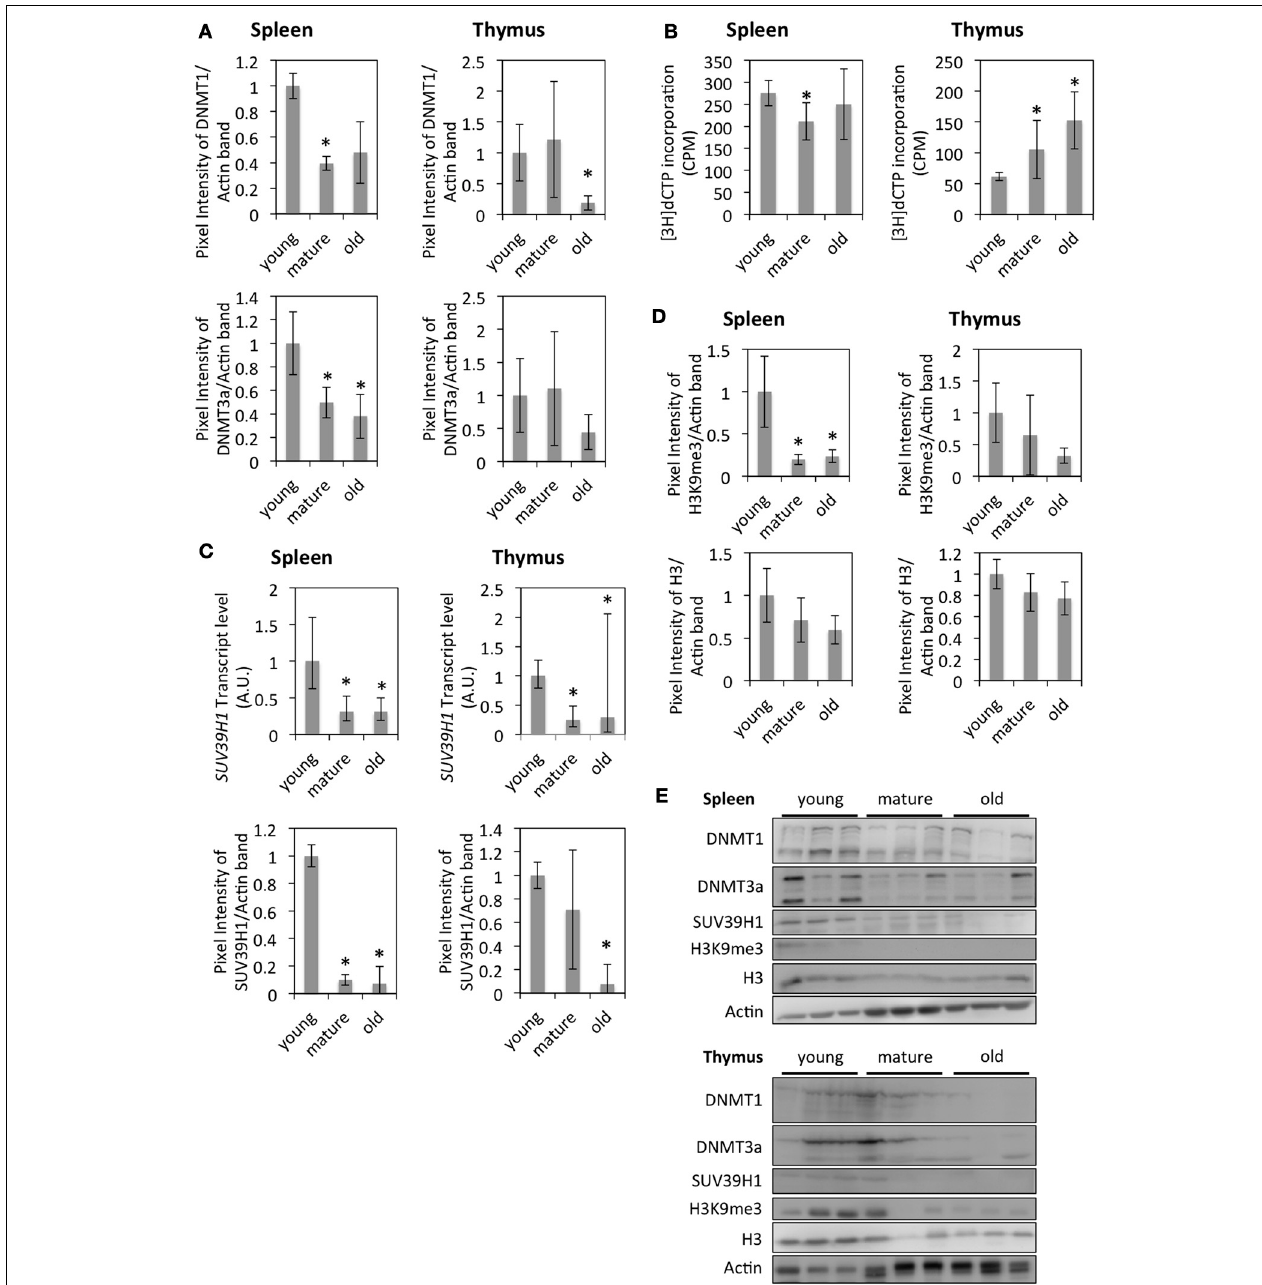
FIGURE 4 | Changes in epigenetic regulation in the thymus and spleen of aging rats. (A) Protein levels of DNMT1 and DNMT3a. The bars represent means normalized to Actin expression and expression in young animals ± standard deviation. (B) Global DNA methylation levels as measured by the Cytosine Extension assay. The bars represent mean ± standard deviations. (C) RNA and protein expression levels of histone modifying enzymes as measured by qRT-PCR or Western blot. For qRT-PCR graphs, the bars represent mean standardized to expression levels in young animals. The error